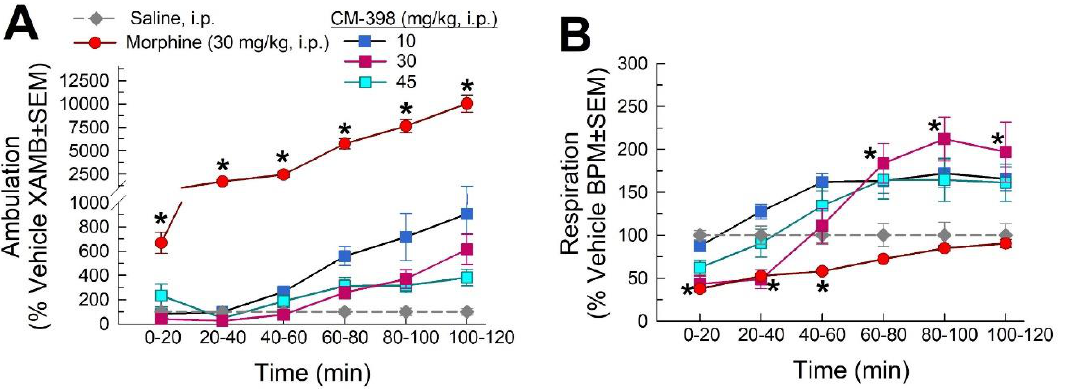
Figure 7. Evaluation of potential effects of CM-398 on ( A ) spontaneous ambulation and ( B ) respiration in C57BL/6J mice. Ambulation and respiration were monitored after i.p. administration of CM-398 (10, 30, or 45 mg/kg; squares), saline (grey diamonds), or morphine (30 mg/kg, red circles) using the CLAMS/Oxymax system. Data are presented as % vehicle response ± SEM for ambulation (XAMB, ( A )), or breaths per minute (BPM, ( B )); * = significantly different from baseline response ( p < 0.05); n = 12 mice/treatment.